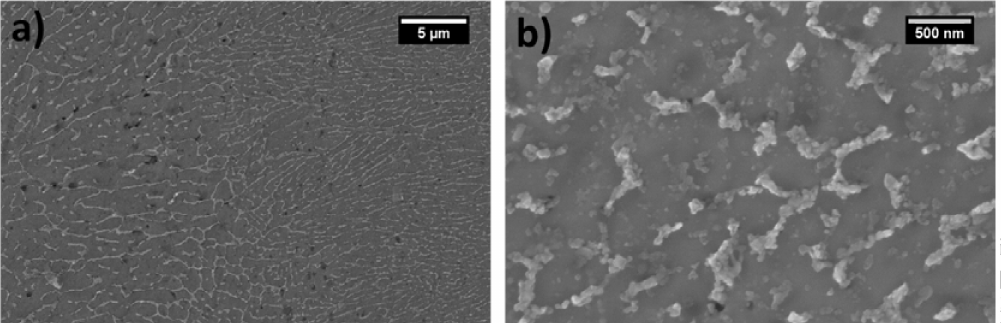
Figure 5. Optical micrographs of 50% 7075 etched samples built ( a ) without the 67 ◦ rotating scanning strategy; ( b – d ) with the rotating scanning strategy and the optimized parameters.